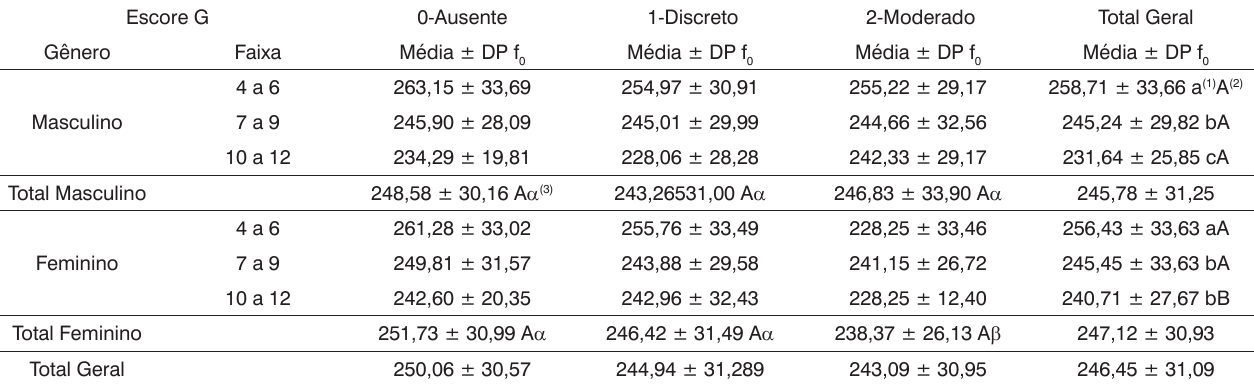
Tabela 6. Valores médios e desvio padrão (DP) da frequência fundamental (f escala GRBASI, o gênero e a faixa etária (em anos).